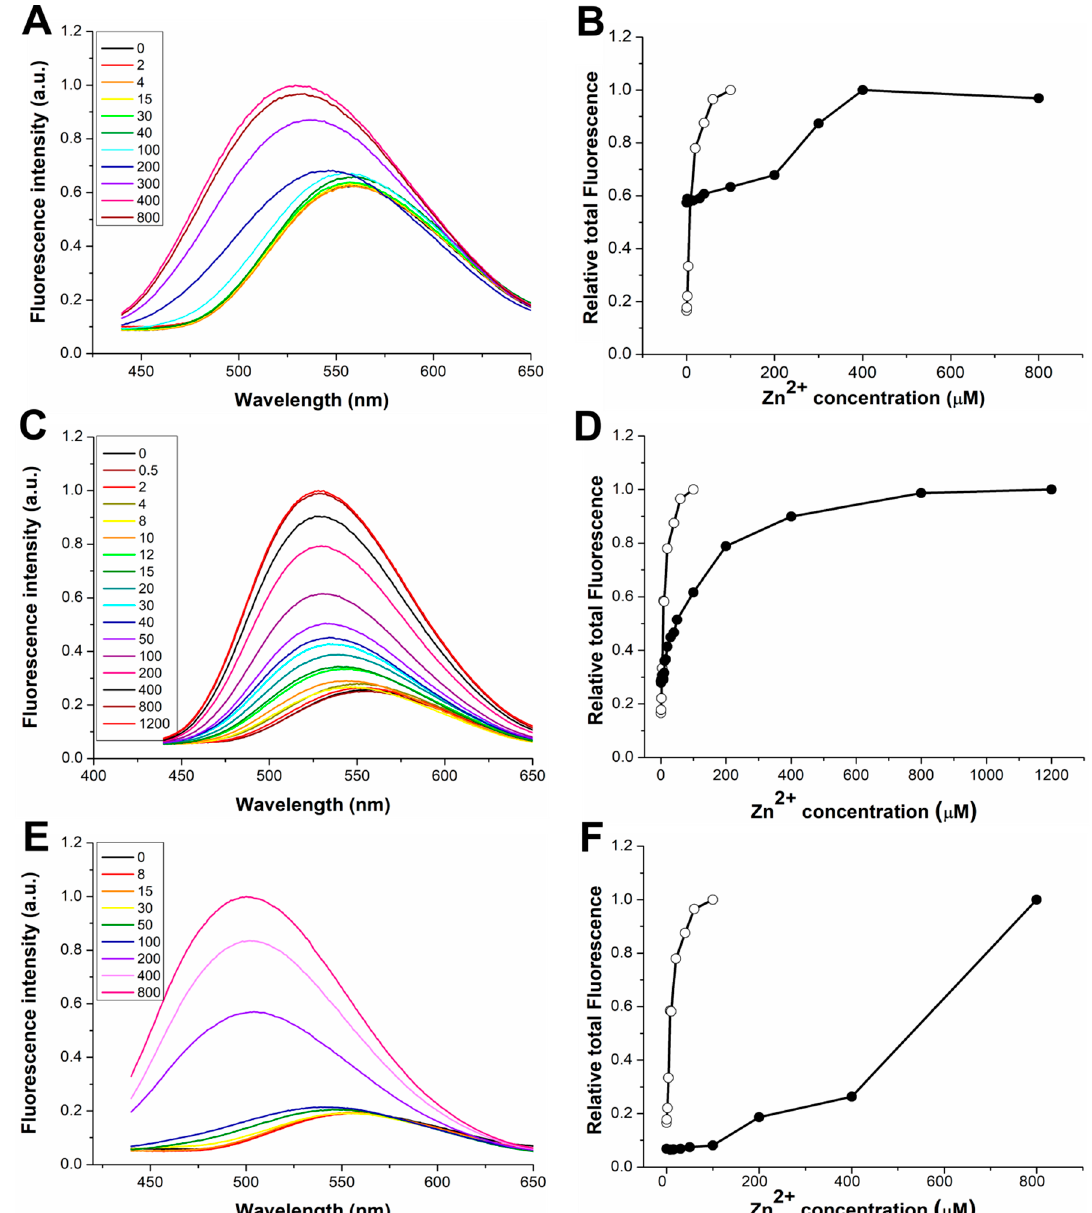
Figure 1. Fluorescence response of dH3w(H1A), dH3w(H3A), and dH3w(H5A) as function of Zn(II) concentration. Emission spectra of ( A ) dH3w(H1A), ( C ) dH3w(H3A), and ( E ) dH3w(H5A). The legends show the concentrations of Zn(II) in μ M units. Normalized area of the fluorescence emission as function of the Zn(II) concentration for ( B ) dH3w(H1A), ( D ) dH3w(H3A), and ( F ) dH3w(H5A) (filled circles), respectively. For comparison, the normalized area of the fluorescence emission of dansyl-HPHGHW-NH 2 (dH3w) is also reported in each panel (void circles). Spectra were registered after excitation at 340 nm (the absorption maximum of the dansyl moiety) in 20 mM 3-(N-morpholino)propanesulfonic acid (MOPS) buffer, pH 7 at 25 °C.